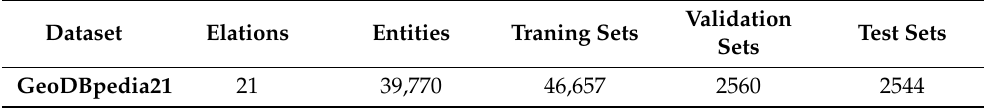
Table 4. The statistics of